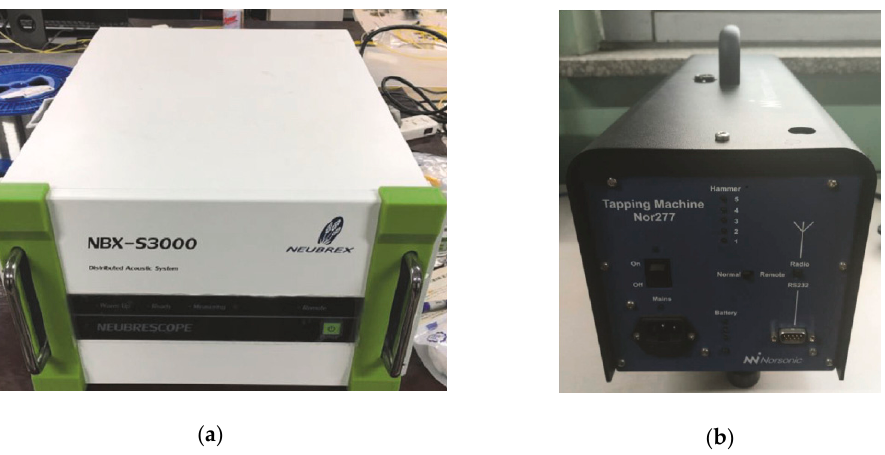
Figure 18. ( a ) NBX-S3000 and ( b ) vibratory equipment.